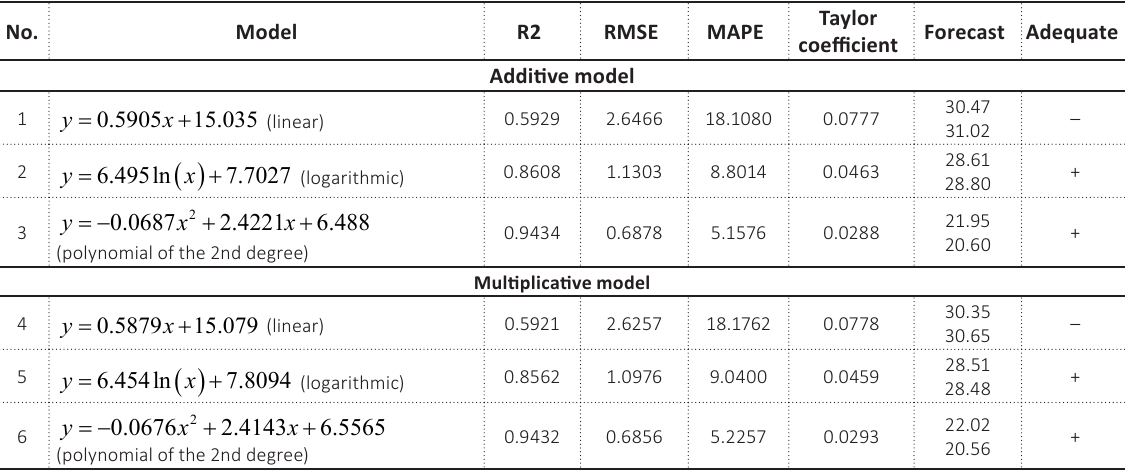
Table 3. Trend equations of multiplicative and additive models (forecast for the 3rd and